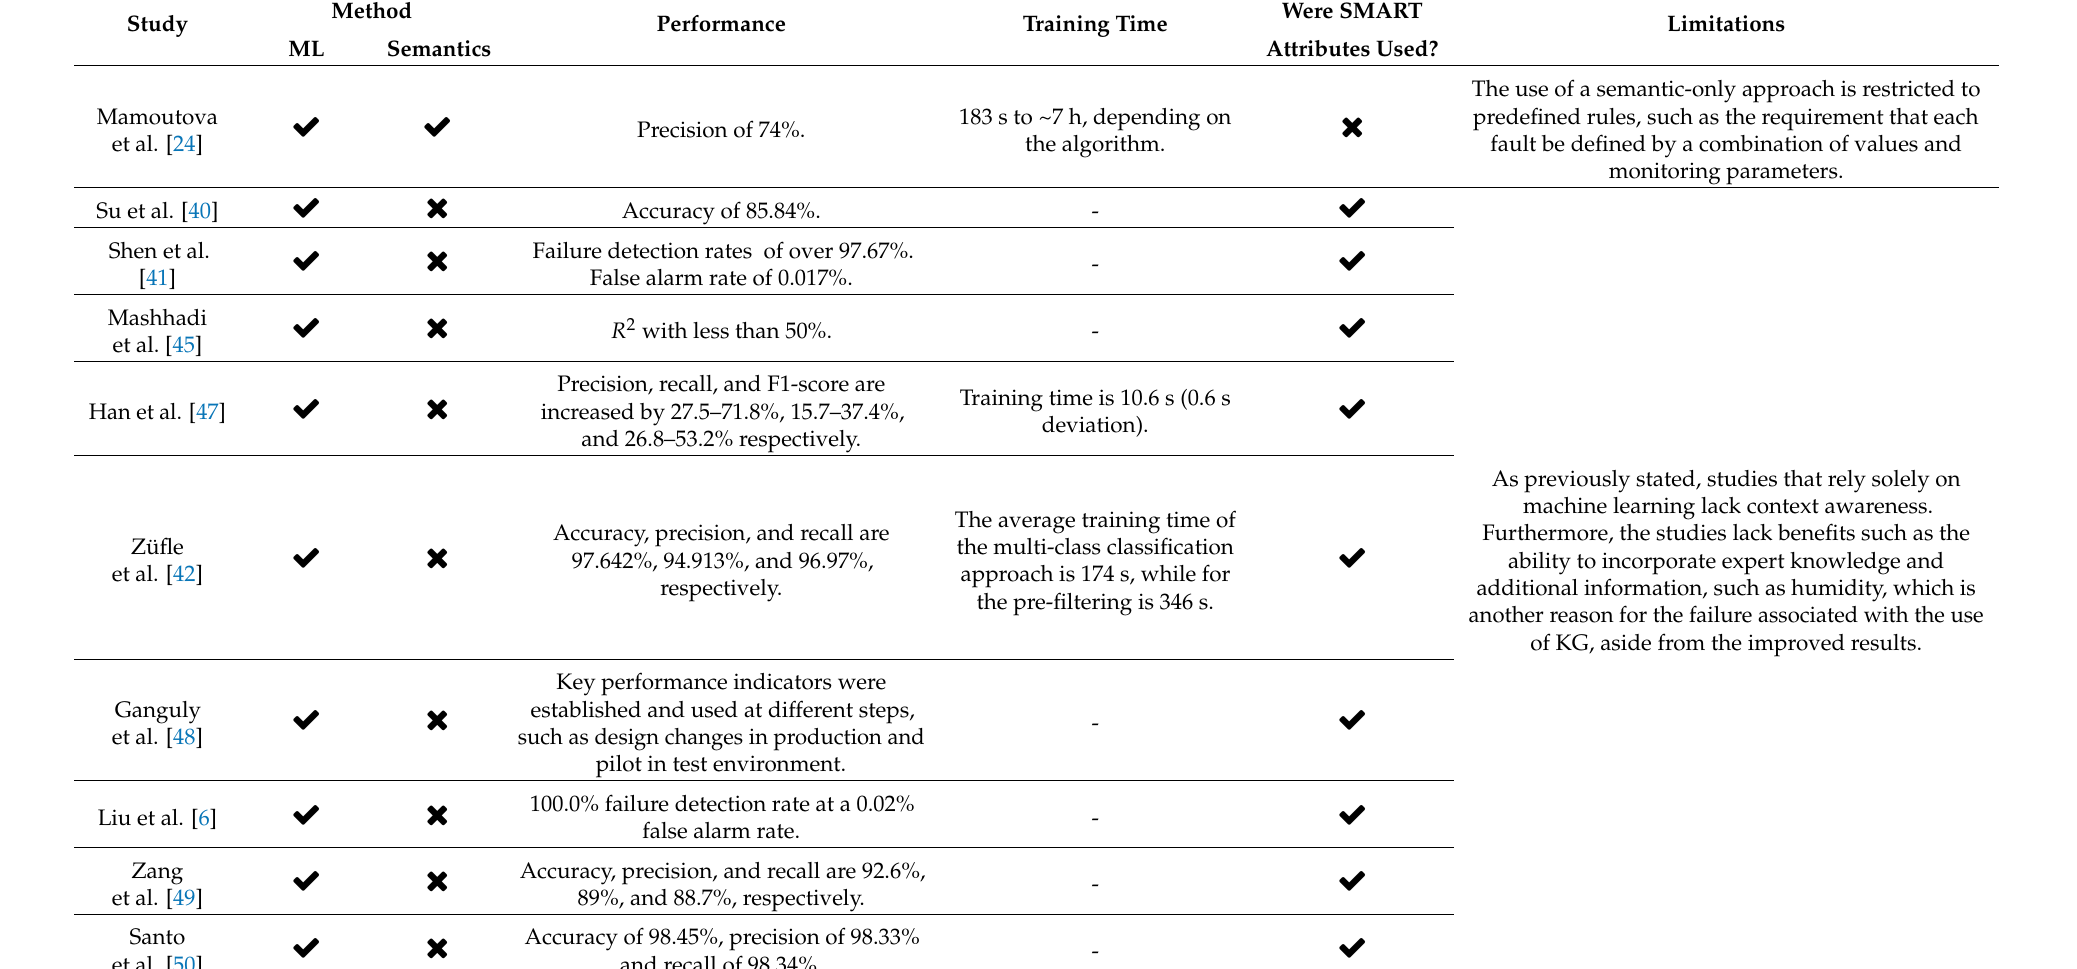
Table 1. Summary of existing HD PdM